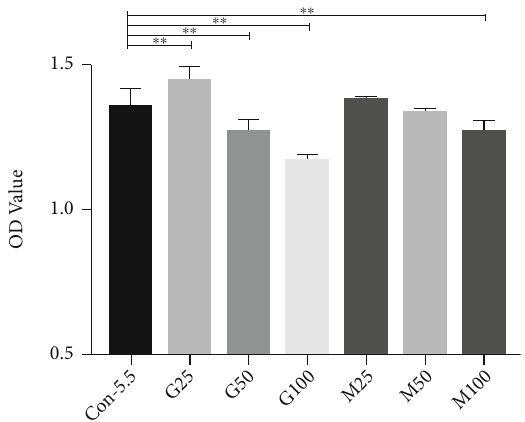
Figure 1: Cell proliferative ability of HRMECs using the CCK-8 assay. At 48h after culturing, compared to the control group, increased cell proliferation at 48 was found in the G25 group, while the OD value was signi fi cantly lower in the G50 and G100 groups. No signi fi cant di ff erence was observed between the hypertonic group and the control group. Con-5.5, G25-G100: concentration of glucose (5.5, 25, 50, and 100mmol/l, respectively); M25-M100: concentration of M-mannitol (19.5, 44.5, and 94.5mmol/l, respectively). CCK-8: Cell Counting Kit-8 assay. HRMEC: human retinal endothelial cell. OD value: optical density value. ∗ p < 0 : 05 ; ∗∗ p < 0 : 01